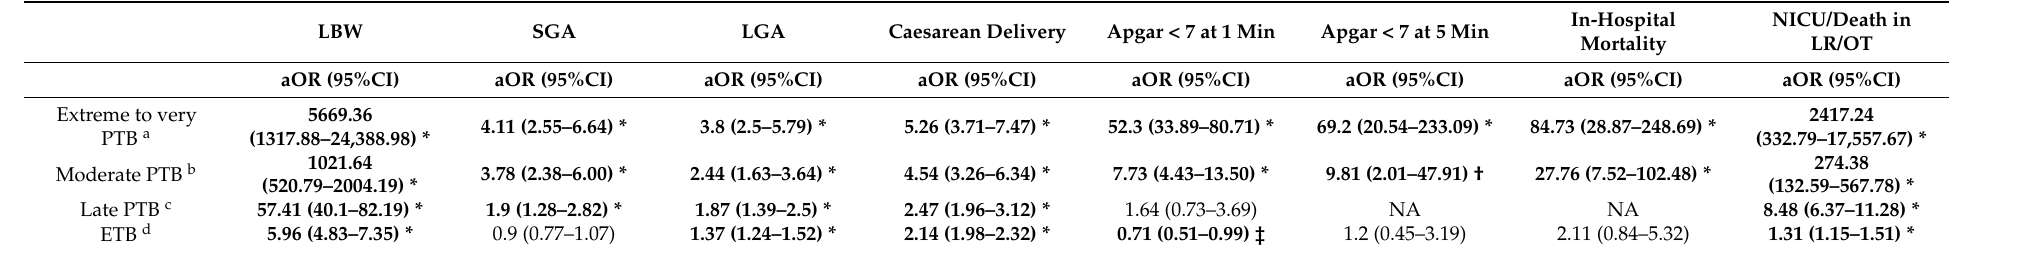
Table 3. Multivariate regression analysis of the pregnancy and feto-maternal outcomes associated with PTB and